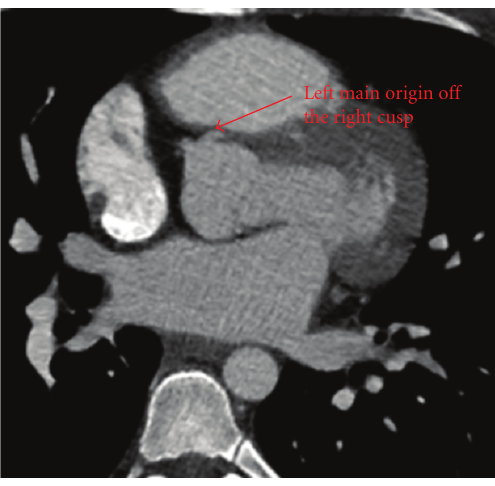
Figure 1: Coronary CT showing the origin of the left main (LM) from the right coronary cusp.